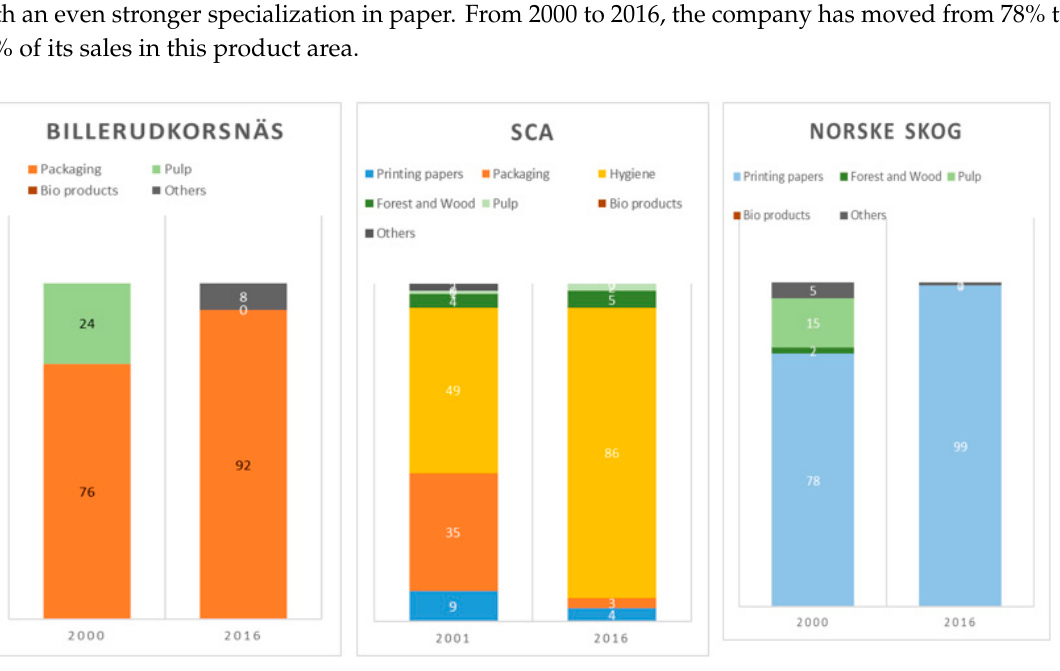
Figure 5. Product portfolio for ‘specialists’. Source: [45–47].